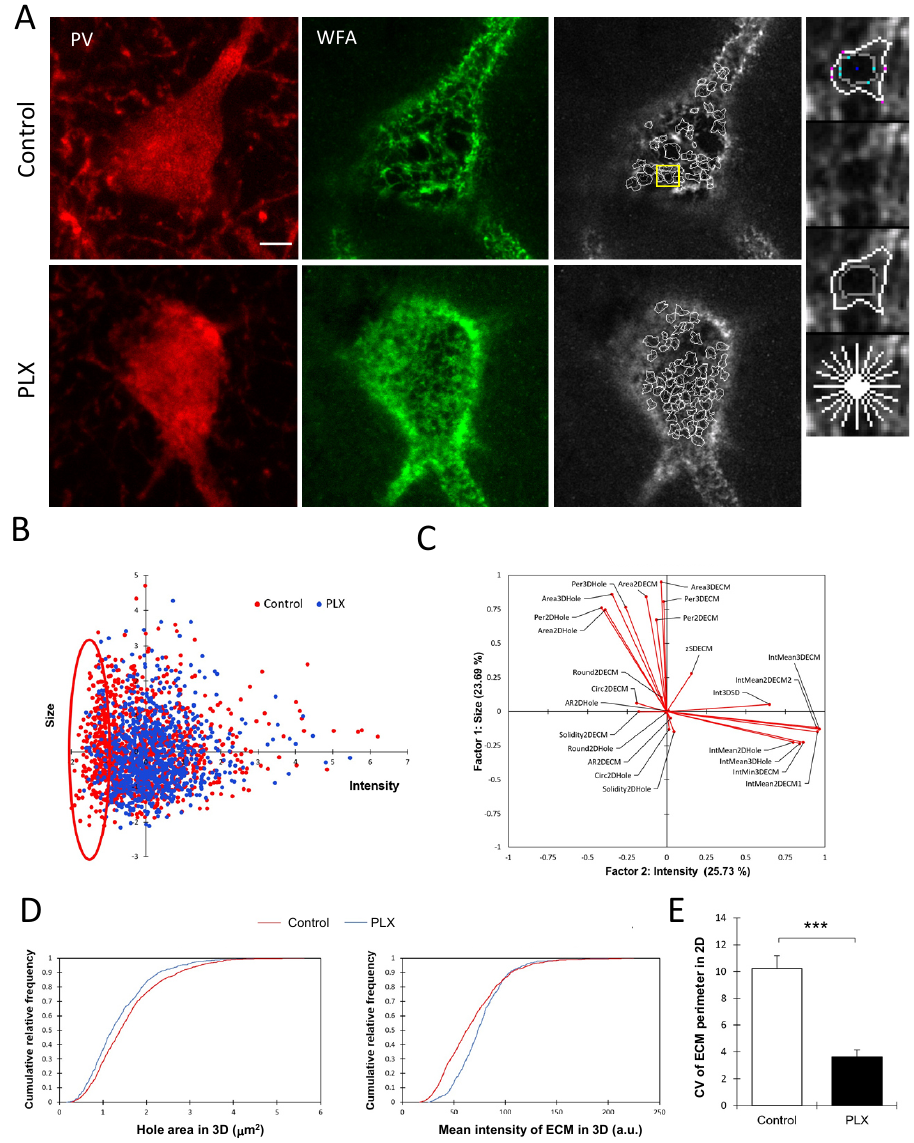
Figure 3. Alterations of PNN fine structure after depletion of microglia. ( A ) Representative images of PNNs surrounding PV+ cells in the hippocampus and corresponding images of PNN units traced by the program in control and PLX-treated animals. The yellow frame indicates the chosen area shown with higher magnification on the right. Scale bar, 5 µ m. ( B ) The factor analysis identifies the intensity and size of PNN units to be the most informative factors explaining 26% and 24% of the total variance, respectively. The scatter plot of individual PNN units in the space of these two factors reveals a fraction of PNN units with low-intensity ECM that disappears after PLX treatment. ( C ) Loads of measured variables on two principal factors. ( D ) Comparison of cumulative distribution functions to visualize an increase in ECM intensity and reduction in the hole area after PLX treatment. ( E ) Coefficient of variation analysis of ECM boundary perimeter shows that PNN units are more uniform per animal after PLX treatment: *** p = 0.001, t -test, n = 4 for both